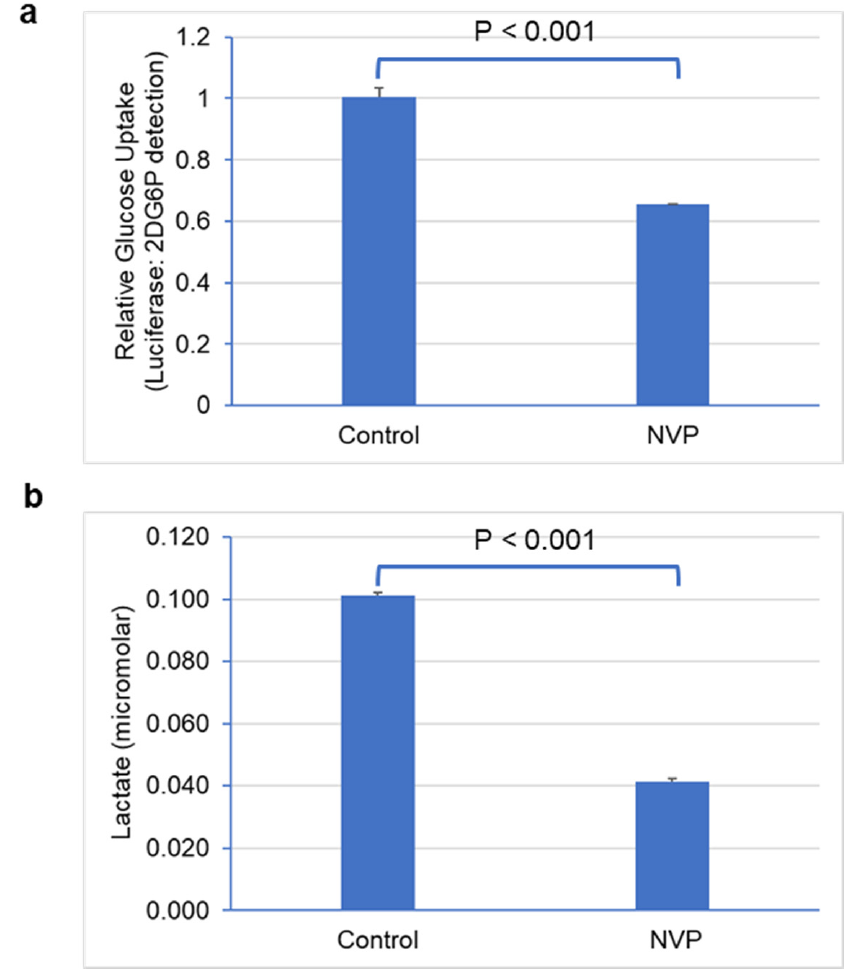
Figure 8. NVP-BEZ235 treatment reduced glucose uptake and lactate secretion. ( a ) Glucose uptake and ( b ) lactate secretion in control DMSO and NVP-BEZ235-treated (1 μ M) samples were measured with luminescence assay. The error bars represent the standard deviation of the samples. Significance was determined by Student’s t-test.